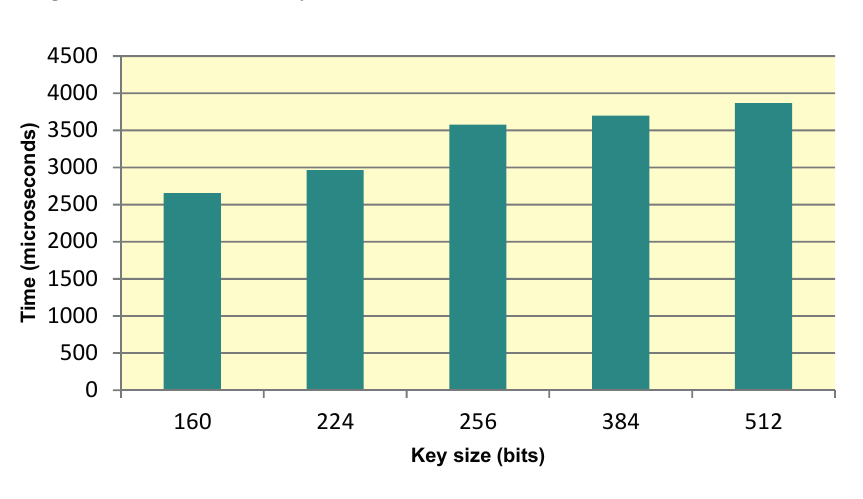
Figure 7. Execution times for ICMetric based symmetric key